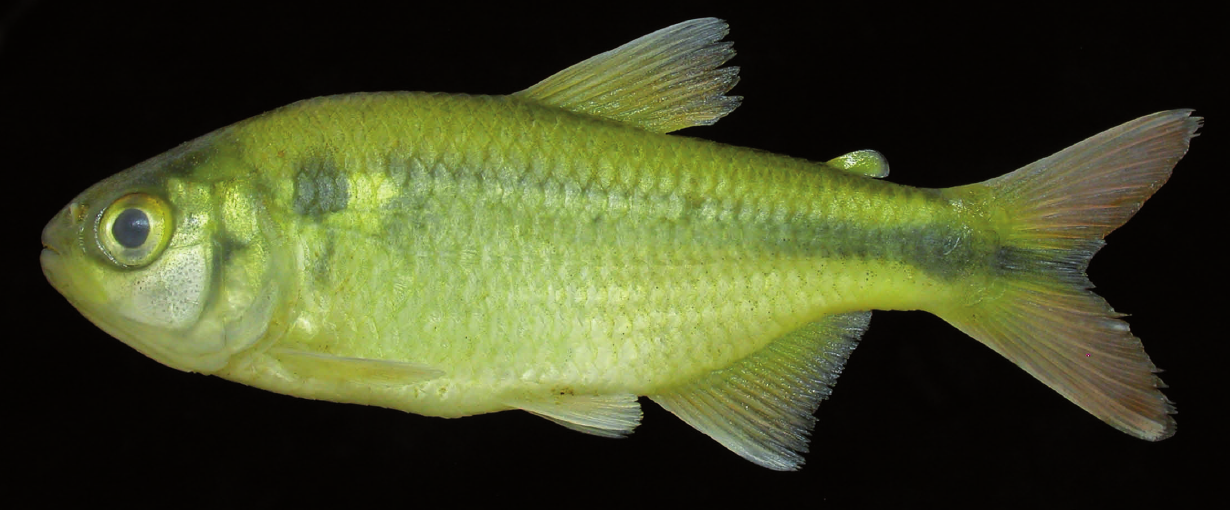
Fig. 2. Astyanax obscurus , MCP 40000, 59.2 mm SL, rio Cadeia above the large waterfalls, Santa Maria do Herval, Rio Grande do Sul,